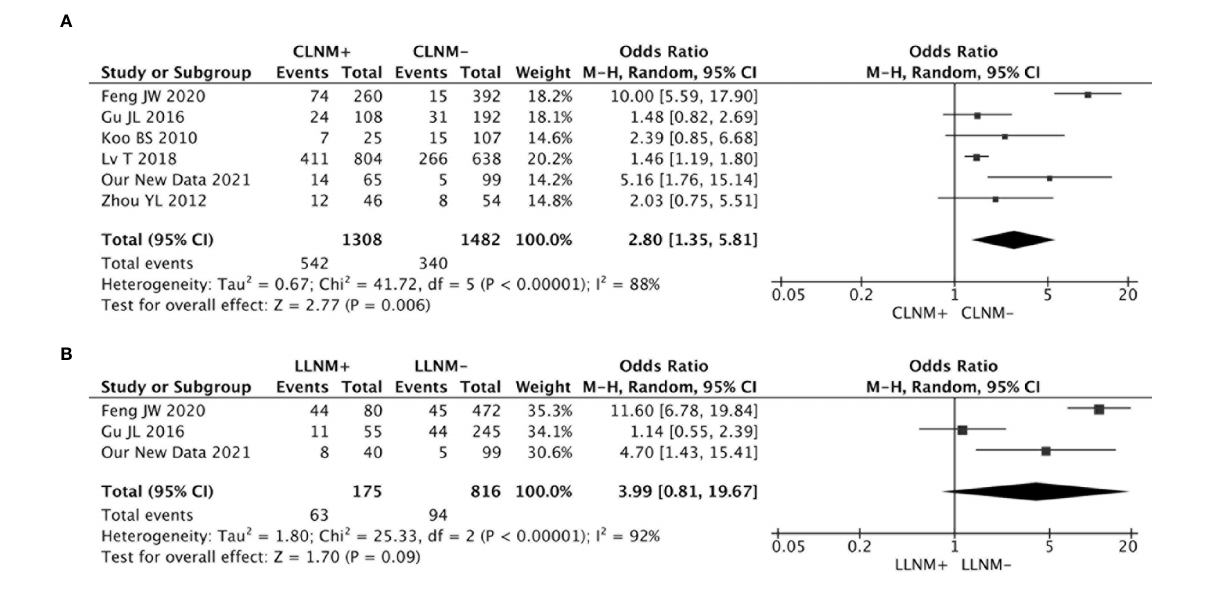
FIGURE 4 | (A) The risk of contralateral occult PTC was signi fi cantly higher in patients with CLNM than patients without CLNM (pooled OR = 2.80, 95% CI = 1.35 – 5.81, p = 0.006); (B) There was no signi fi cant association between LLNM and contralateral occult PTC (pooled OR = 3.99, 95% CI = 0.81 – 19.67, p =